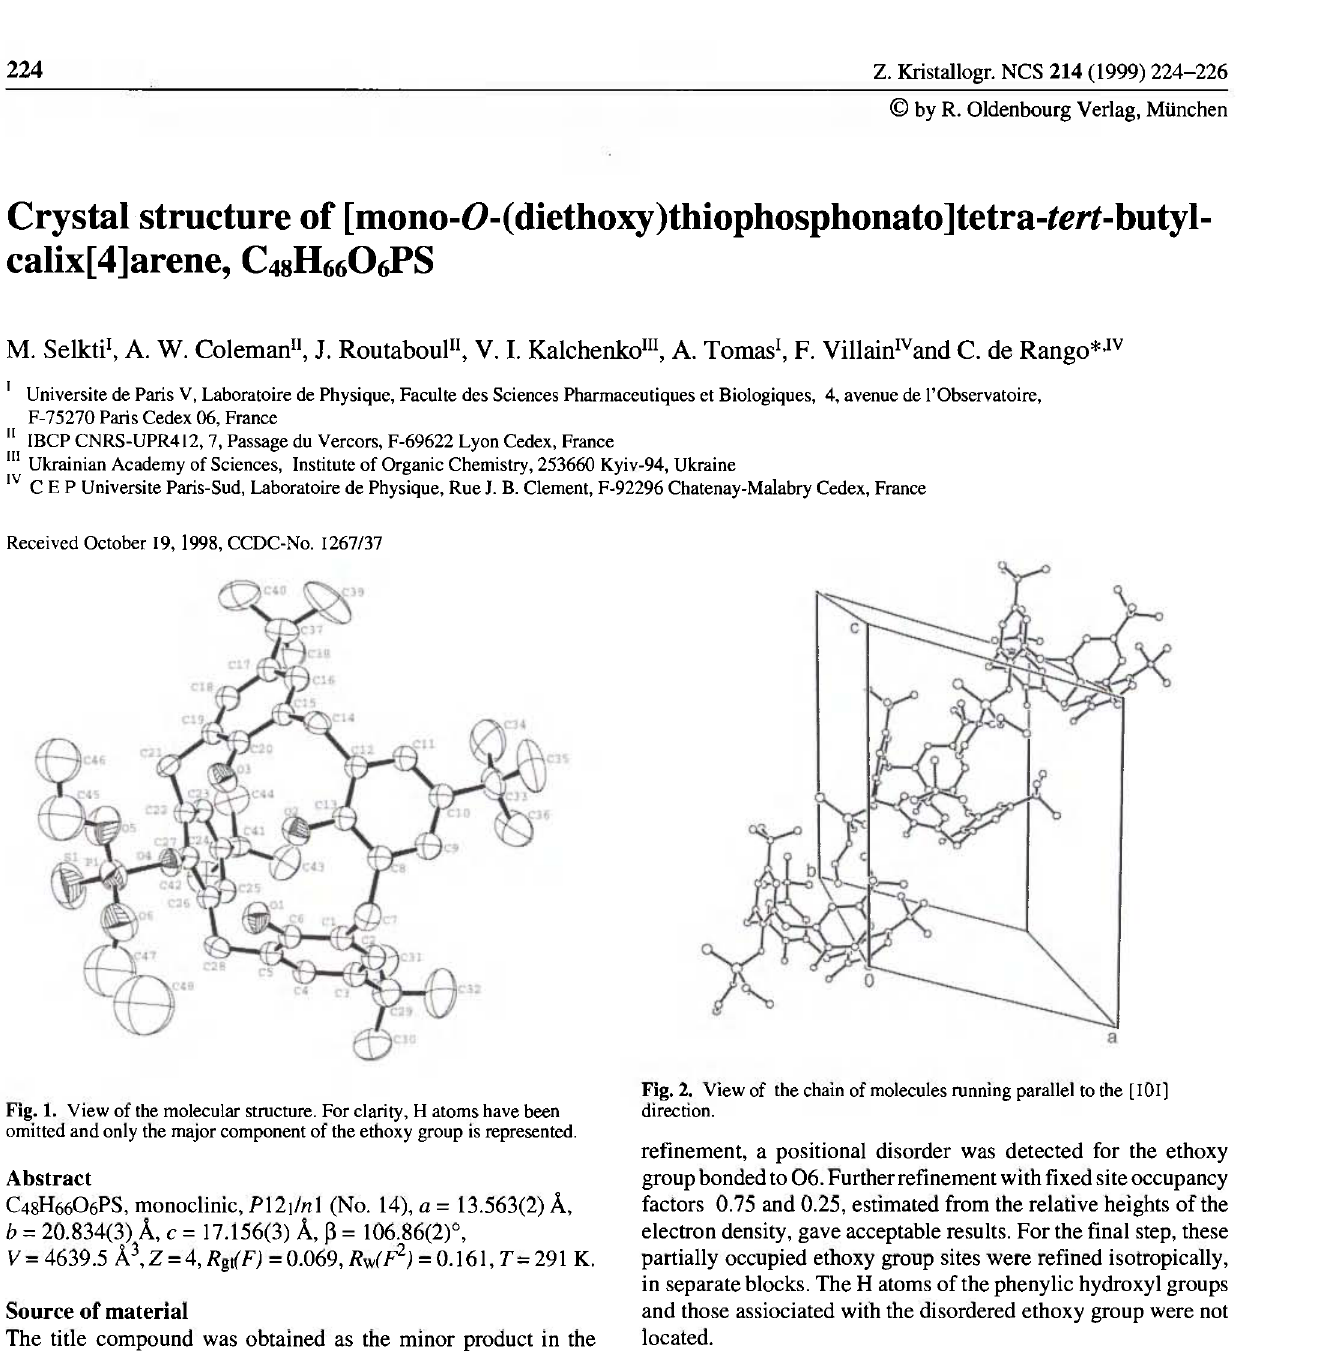
Fig. 2. View of the chain of molecules running parallel to the [101]